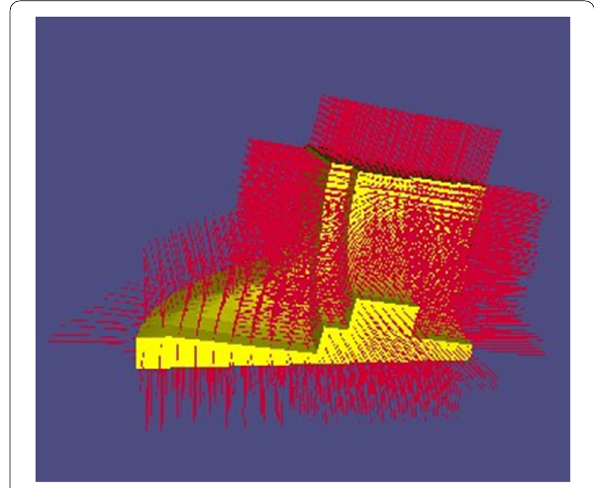
Fig. 4 Outer normal vectors (red lines) on the mesh